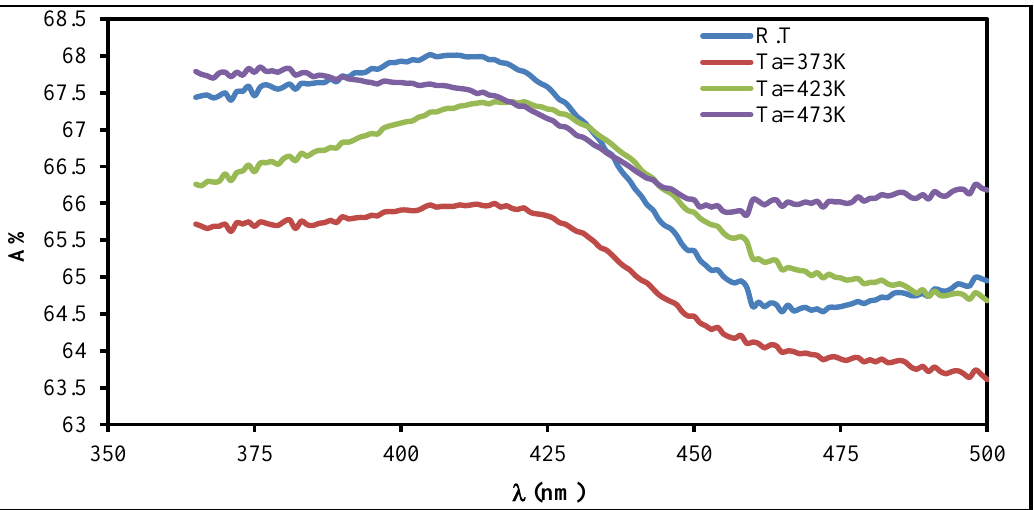
Fig. 2: Absorption spectra of as-deposited and annealed Alq different